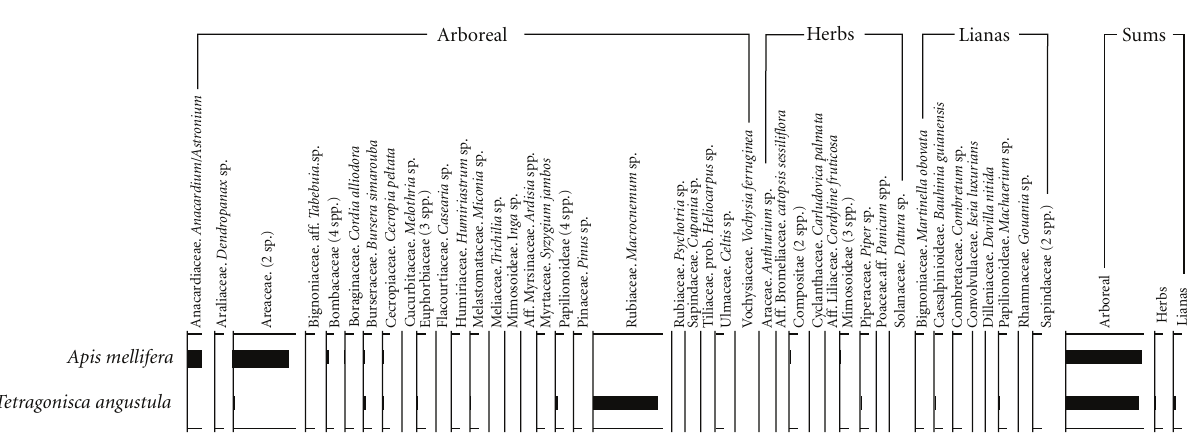
Arboreal Herbs Lianas Sums